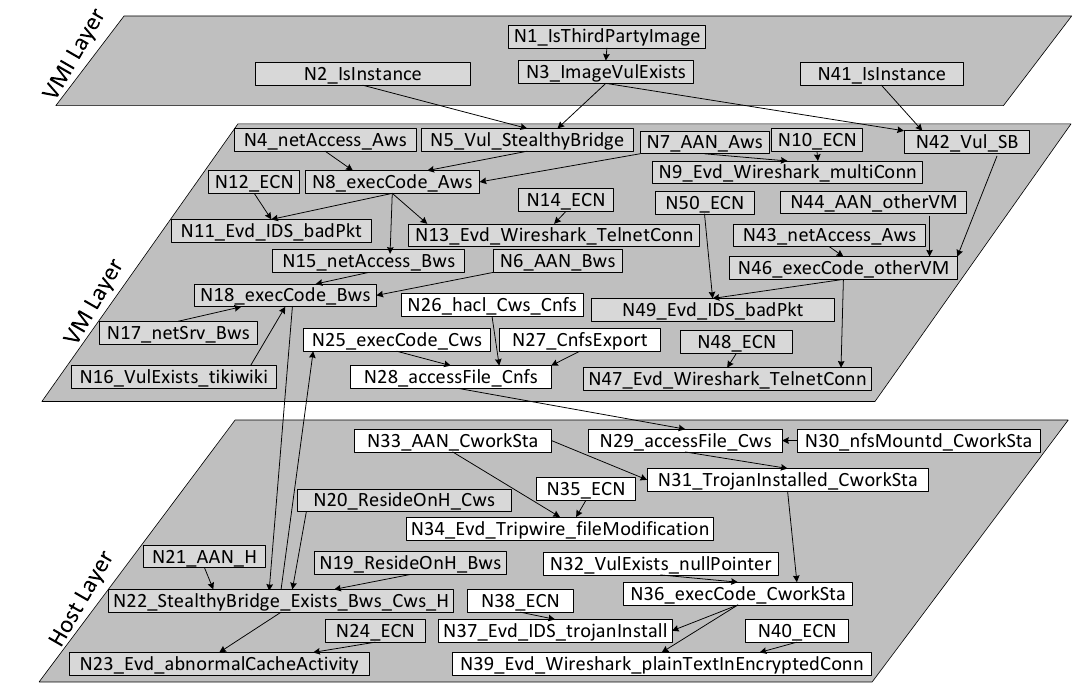
Figure 8. The Cross-Layer Bayesian Network Constructed for the Attack